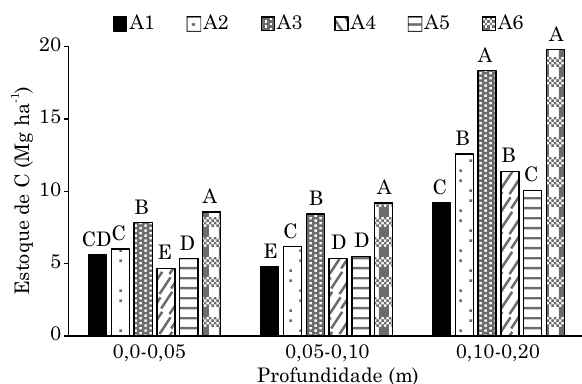
Figura 2. Estoque de carbono (EstC), nas profundidades de 0,00-0,05; 0,05-0,10; e 0,10-0,20 m, nas áreas estudadas, após impacto ambiental.